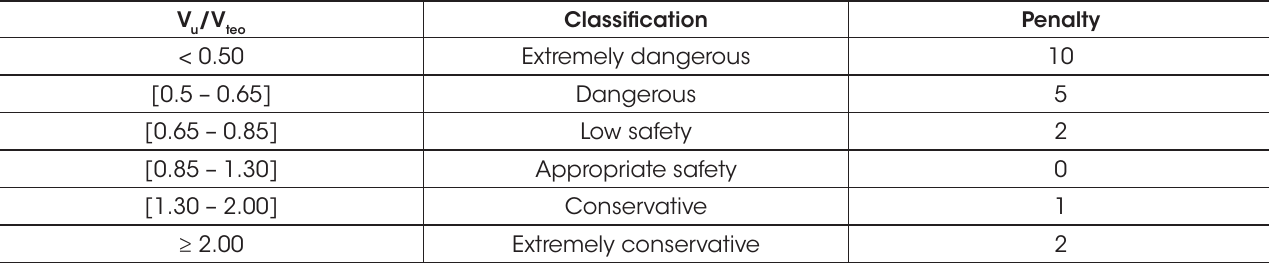
Demerit scale, according to the criterion of COLLINS [7]